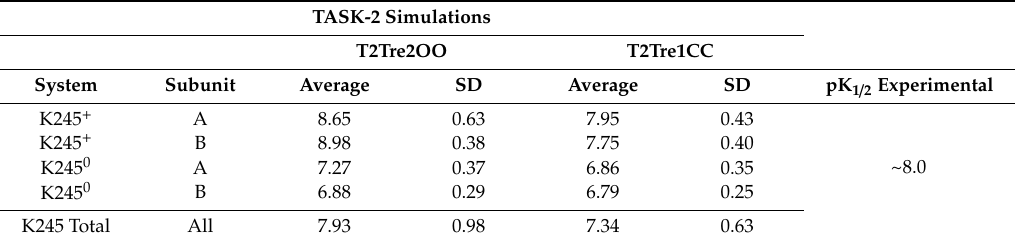
Table 1. The pKa prediction of K245 residue over MD trajectories. The pKa prediction was computed over the last 50 ns of simulation and averaged over three replicas ( n = 300) for each system: T2Tre2OO-K245 + , T2Tre2OO-K245 0 , T2Tre1CC-K245 + , and T2Tre1CC-K245 0 . The calculation was carried out by considering only the channel and membrane atoms explicitly. K245 total corresponds to the average ± SD of the system protonated and neutral ( n = 1200). The pK 1/2 value reported by Niemeyer et al. [7] is used as a parameter to compare the pKa of K245 predicted in K245 total for open (T2Tre2OO model) and closed (T2Tre1CC model) states of the